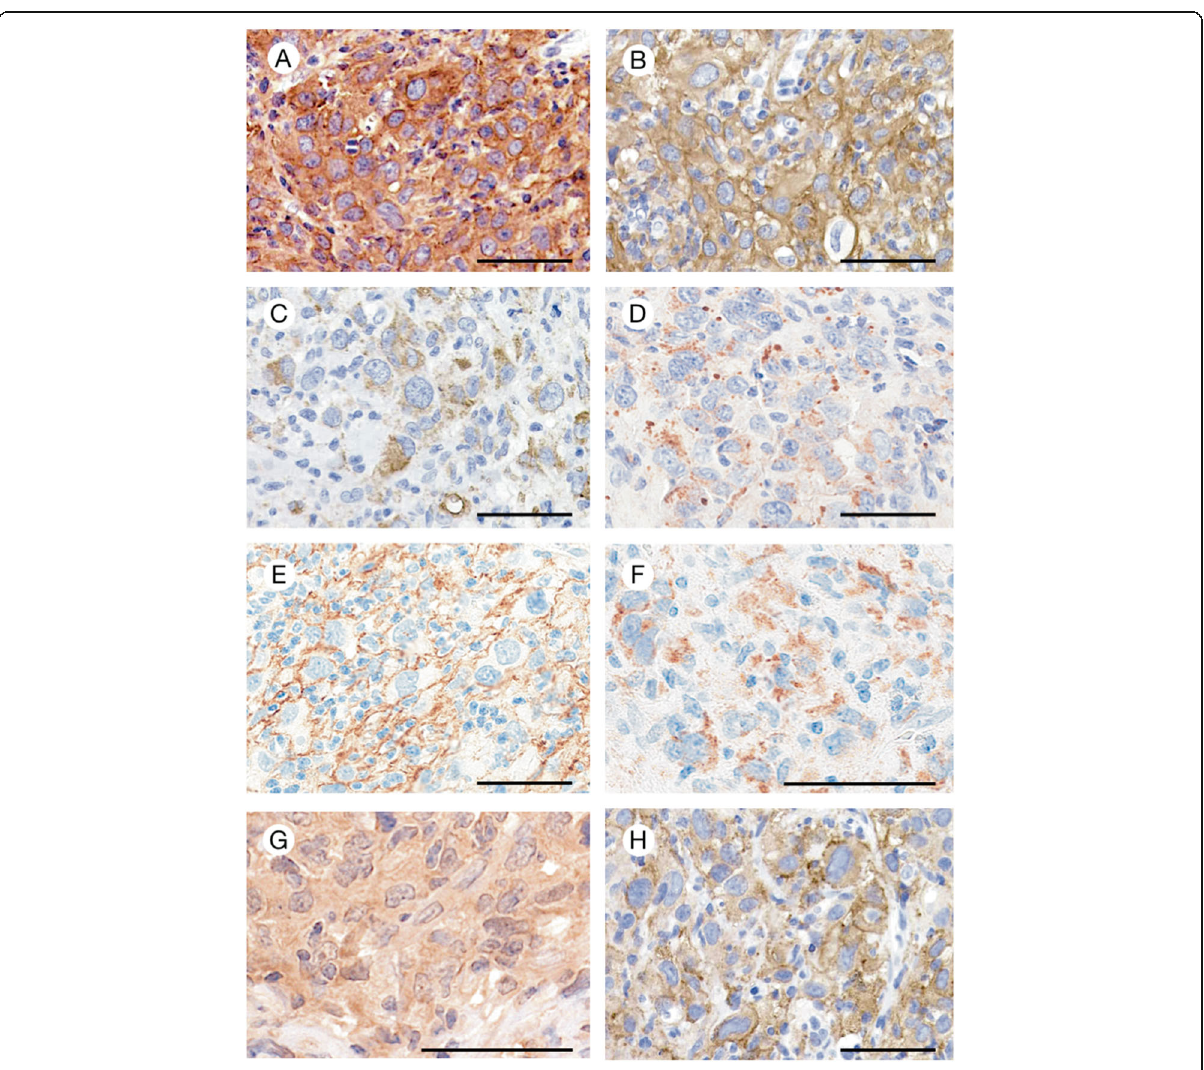
Fig. 4 Immunophenotypic finding of the lymph node: Large neoplastic cells were positive for histiocytic markers, such as CD68 ( a ), CD163 ( b ), LN5 ( c ), LIGHT ( d ; clone 4E3, Santa Cruz Biotechnology), and PD-L1 ( e ; clone E1L3N, Cell Signaling Technology). Neoplastic cells were also positive for BRAF V600E ( f ; clone RM8, Abnova), Eotaxin-2 ( g ; clone G-17, Santa Cruz Biotechnology), and DC-SIGN ( h ). Bars, 50 μ